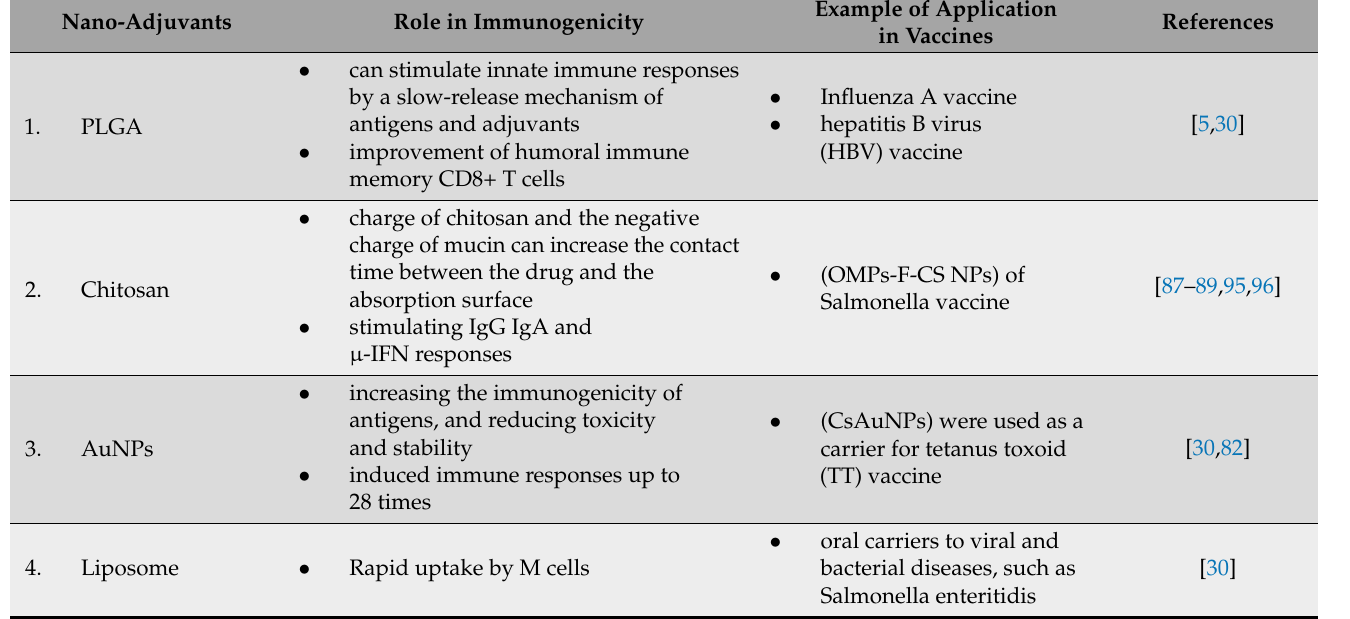
Table 2. Common types of nano-adjuvants and their role in